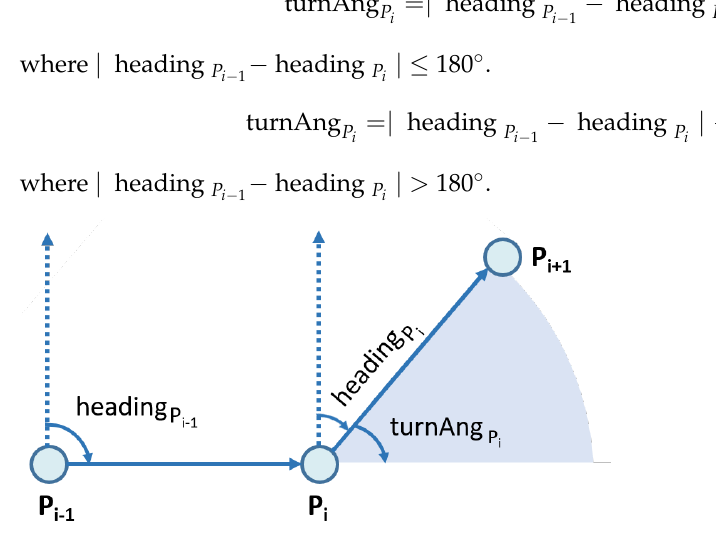
Figure 4. Illustration of heading direction and turning angle